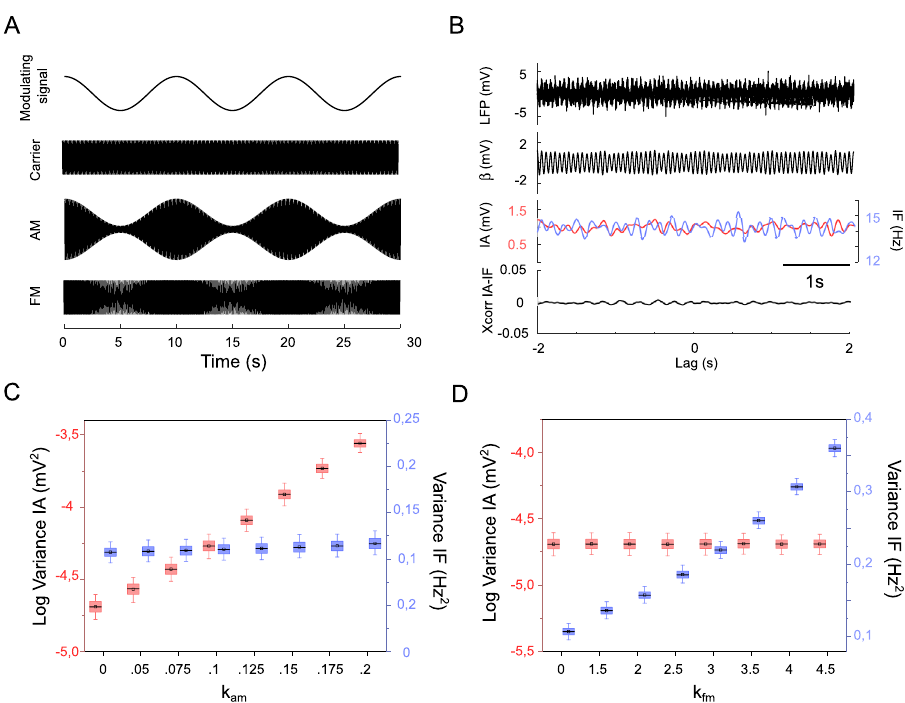
Fig. 1 Simulated amplitude modulation (AM) and frequency modulation (FM). A Illustration of AM and FM. A modulating signal (0.01 Hz) is utilized to modulate the faster “ carrier ” sine wave (14 Hz) by means of alteration of carrier amplitude (i.e. AM) or frequency (i.e. FM). B Amplitude or frequency modulated sine wave combined with white noise to simulate an arti fi cial LFP. The simulated LFP was fi ltered in the beta band ( β , black line) and both instantaneous amplitude (IA, red line) and frequency (IF, blue line) were extracted through Hilbert transform. Bottom, cross-correlation function (Xcorr) calculated between instantaneous amplitude and instantaneous frequency. C , D Boxplots representing the distribution of the logarithmic variance of instantaneous amplitude (AM, red) and the variance of instantaneous frequency (FM, blue), as a function ( C ) of the AM index (k AM ) or ( D ) or the FM index (k AM ). In the boxplots, the central black line indicates the median, the central black square indicates the mean and the box limits indicate the 25th and 75th percentiles. Whiskers at ±1.5 interquartile range. As expected, changing the AM does not affect the FM and viceversa, showing that AM and FM are mathematically independent